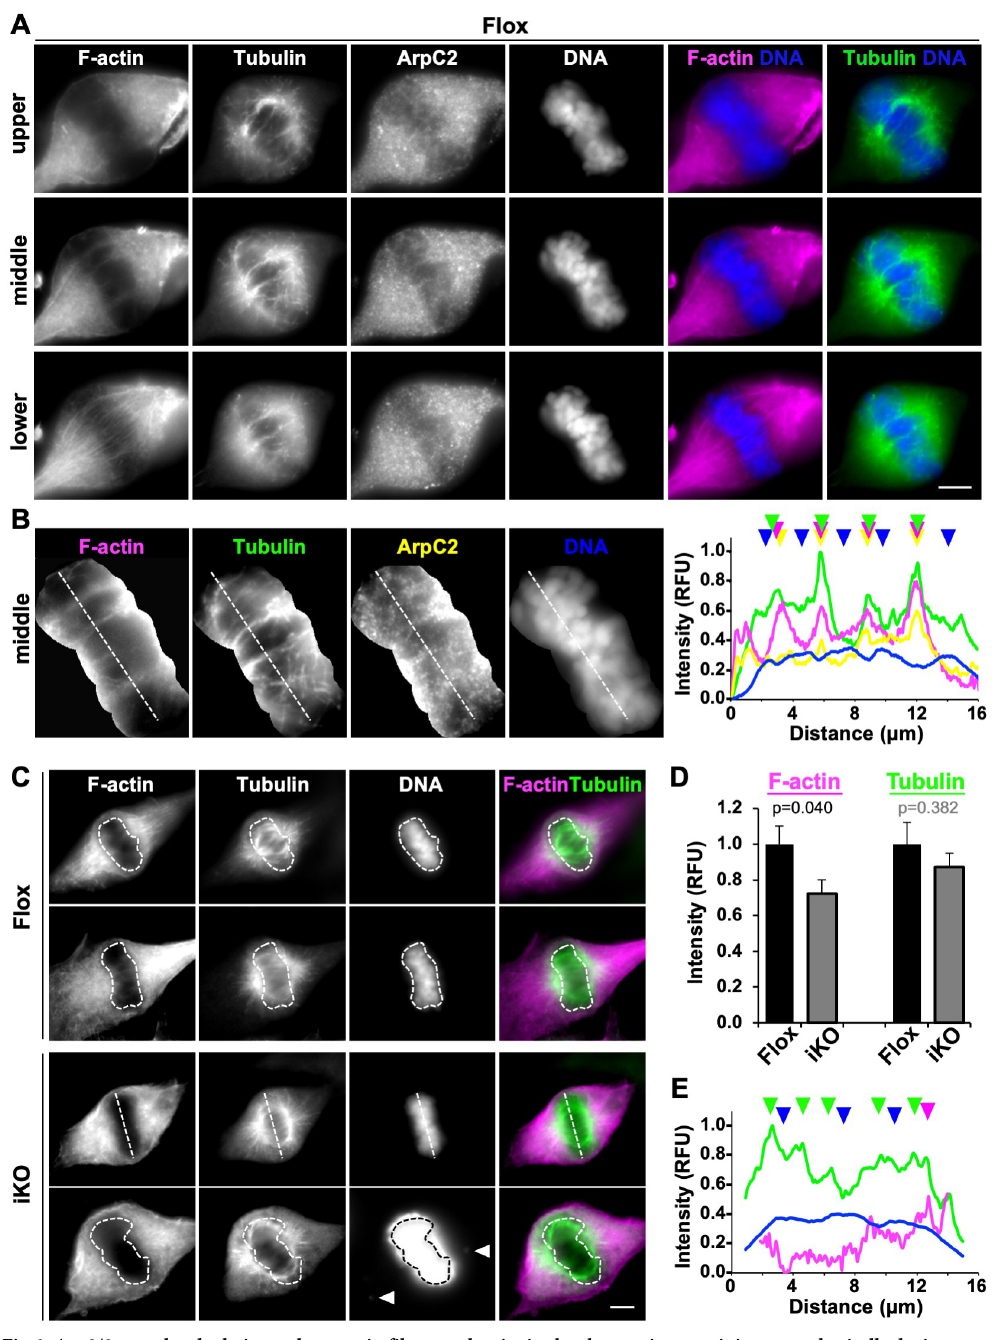
Fig 6. Arp2/3 complex depletion reduces actin filament density in the chromatin-containing central spindle during metaphase. (A) Mouse fibroblasts (Flox) were treated with DMSO for 1-2d, fixed, and stained with phalloidin (F-actin; magenta), an anti-tubulin antibody (green), anti-ArpC2 antibodies, and DAPI (DNA; blue). Images represent the upper, middle, and lower regions of metaphase cells. Scale bars, 5 μ m. (B) The DNA-containing region was isolated from the middle spindle in A, magnified, and subjected to line-scan fluorescence intensity analyses. Plot profiles depict the pixel intensity values for F-actin (magenta), tubulin (green), ArpC2 (yellow), and DNA (blue) along the dashed lines drawn across the representative metaphase region. Color-coded arrowheads highlight the overlapping peaks of F-actin, tubulin, and ArpC2 and the inverse intensity pattern for DNA. RFU = Relative Fluorescence Units. (C) Mouse fibroblasts were treated with DMSO (Flox) or 4-OHT (iKO) for 1-2d, fixed, and stained with phalloidin, an anti-tubulin antibody, and DAPI. The chromatin mass at the central metaphase spindle was outlined in ImageJ (dashed shapes) or a plot-profile line was